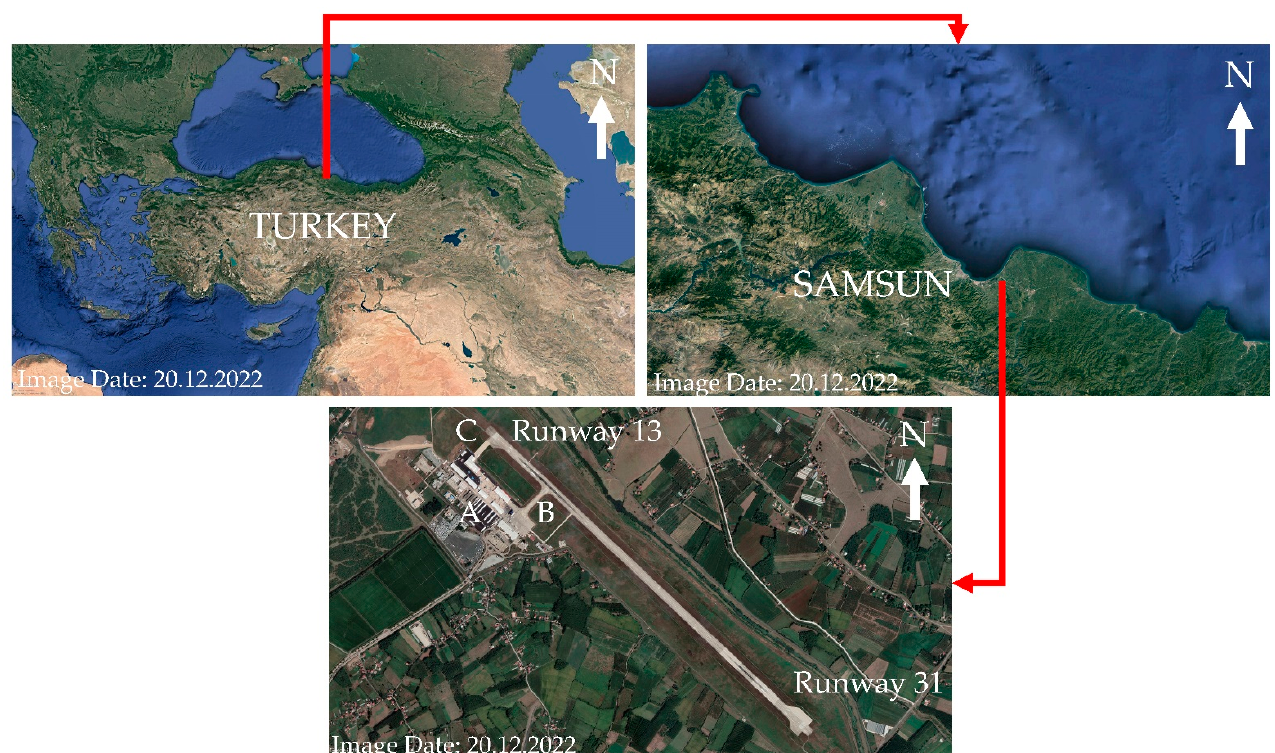
Figure 2. Location and ground layout of Çar ş amba airport, Samsun, Turkey [53].